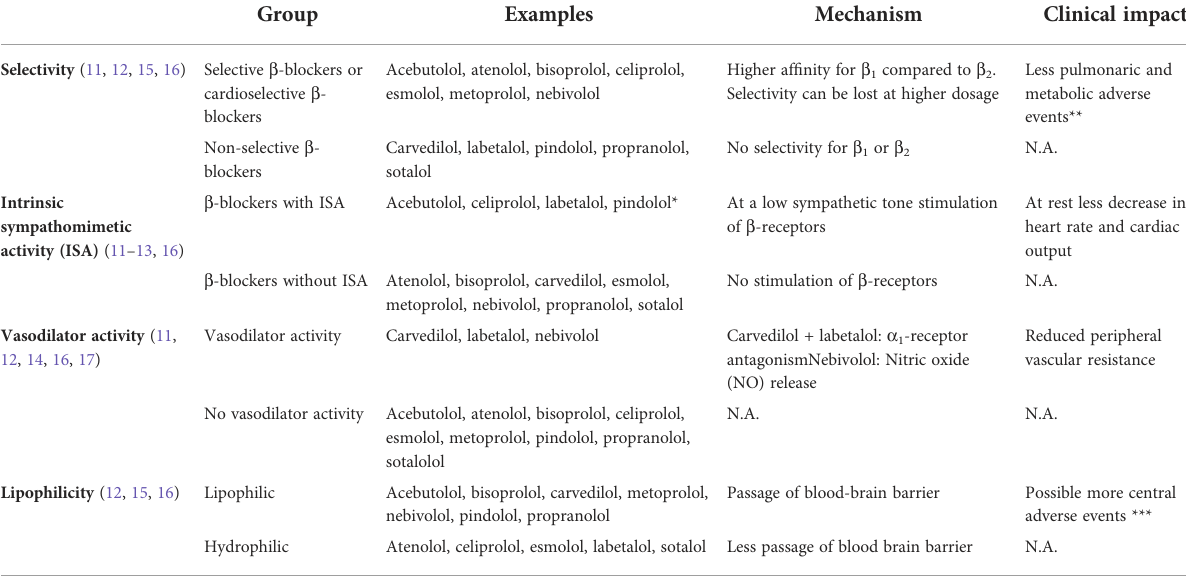
TABLE 1 Properties of b -blockers divided into selectivity, intrinsic sympathomimetic activity and vasodilator activity (11 –